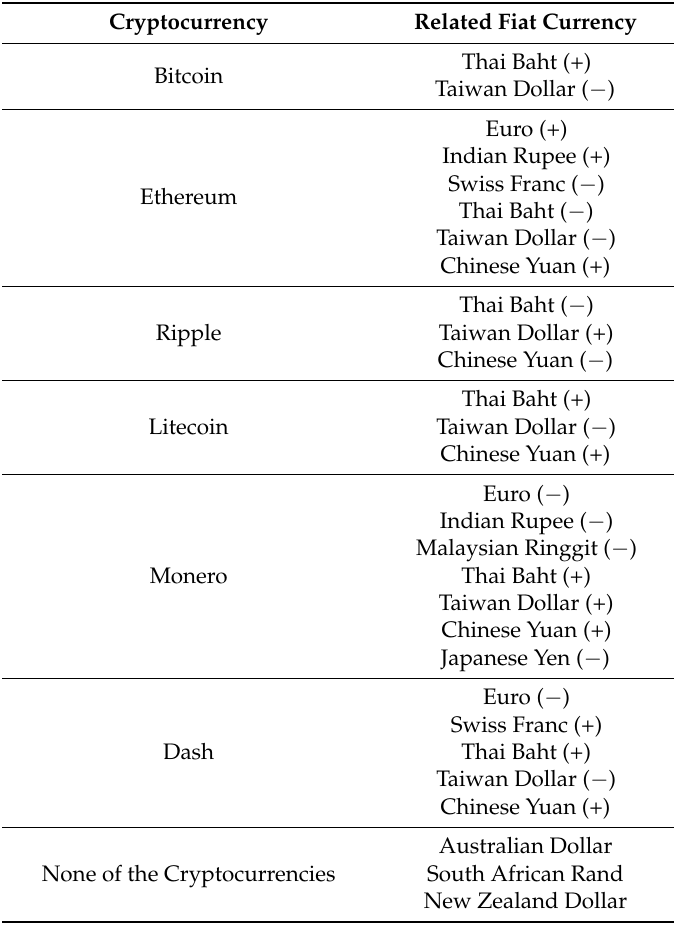
Table 4. Positive (+) and negative ( − ) relationships resulting from the coefficients of the multivariate regression of each cryptocurrency vs. the fiat